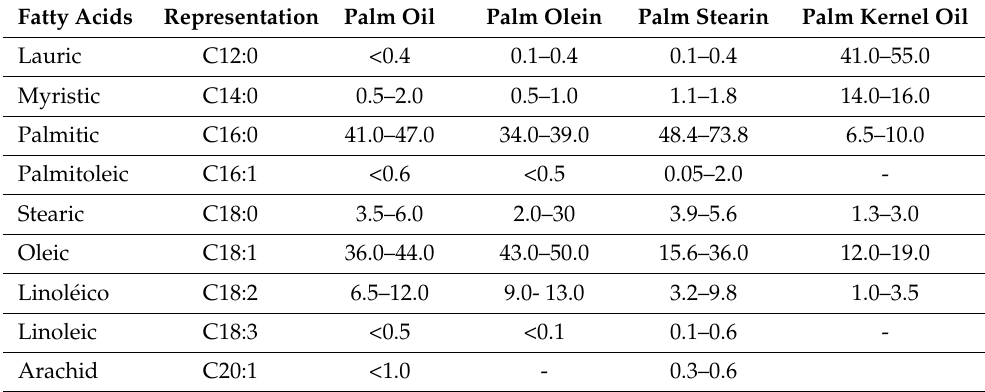
Table 1. Chemical composition of common fatty acids of the palm oil and of the palm kernel [32].